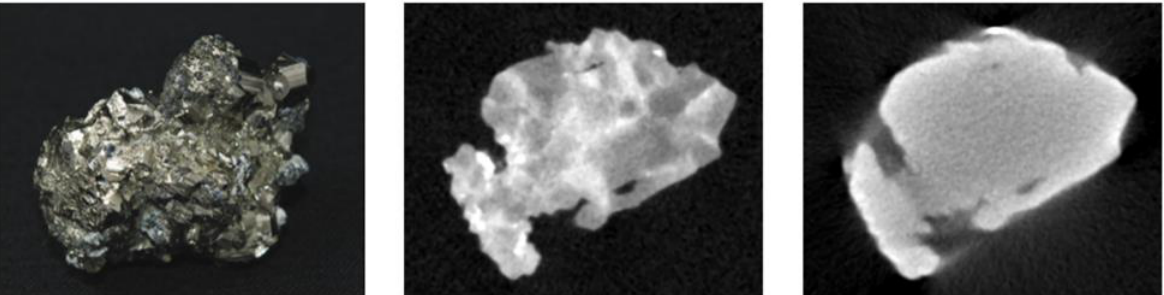
Figure 13. Sample of pyrite (from left to right ): photograph, section from neutron tomography, corresponding section from X-ray tomography (Adapted with permission from ref. [25], Copyright John Wiley and Sons, 2010). The dimension of the sample is approximately 40 mm.